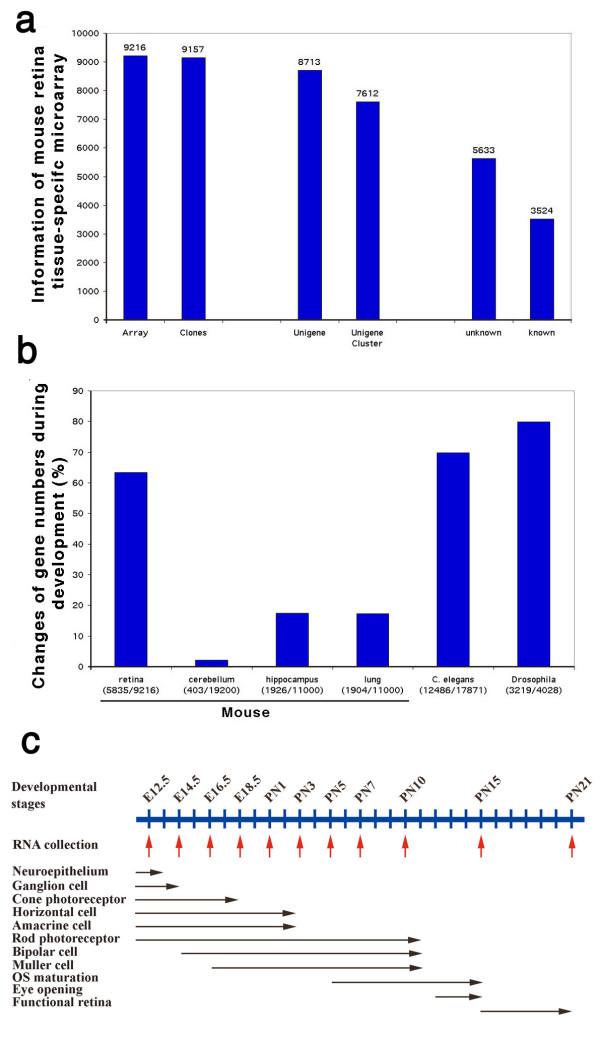
Retina tissue-specific cDNA microarray and gene expression clusters during mouse retina development. a. Composition of retina tissue-specific cDNA microarray. b. Microarray experimental comparison among Drosophila, C. elegans, and distinct mammalian tissues by using different microarray. c. Cell differentiation profiles during mouse retina development and microarray experimental design (text in details).